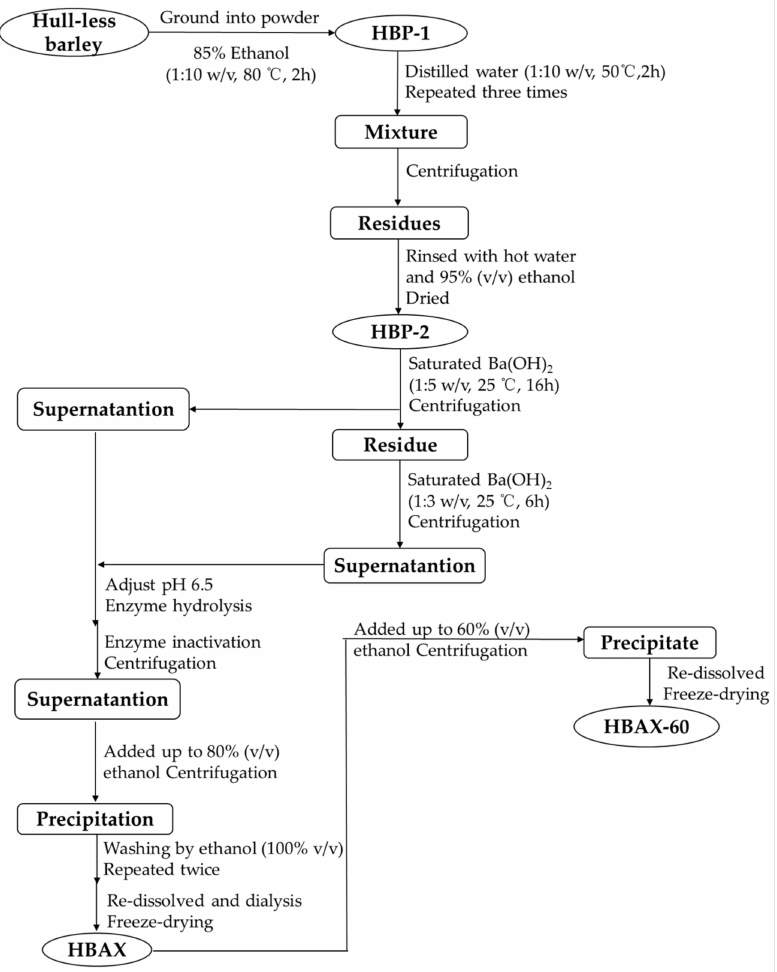
Figure 5. Extraction and purification processes of arabinoxylan from hull-less